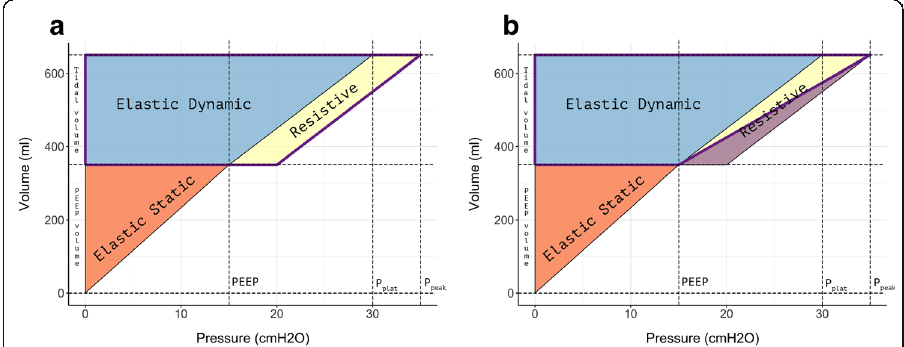
Fig. 2 Geometrical view of mechanical power for volume-controlled ventilation. Left pane ( a ) l: the violet contoured trapezoid represents the mechanical power as calculated with the reference formula (Eq. 1). Right panel ( b ): the violet contoured trapezoid represents the mechanical power as calculated with our unadjusted surrogate (Eq. 3). The violet-filled triangle represents the bias (Eq. 4) between our unadjusted surrogate (Eq. 3) and the reference formula (Eq.